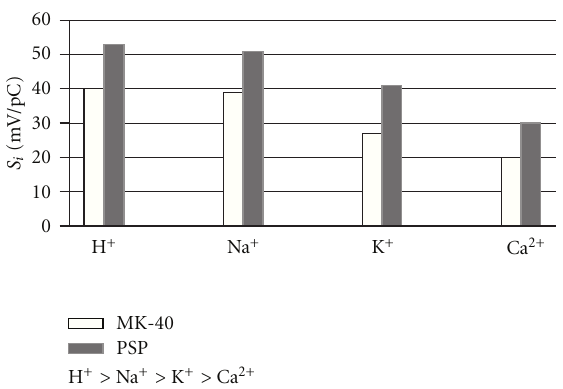
Figure 1: Sensitivity of PD sensors based on PSP and MC-40 in corresponded ionic types in test solutions of HCl, NaCl, KCl, and CaCl 2 .